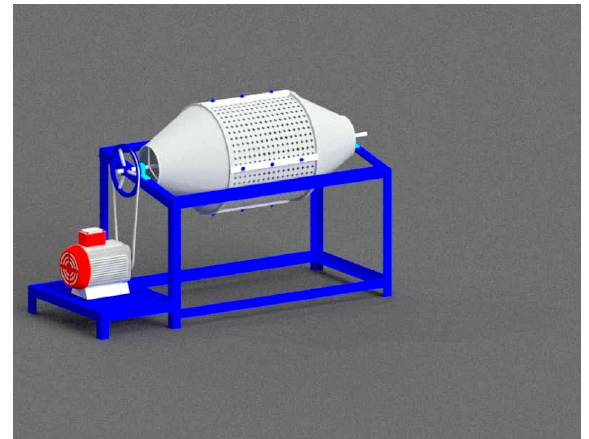
Figure 1. Model of the general purpose tuber-peeling machine.